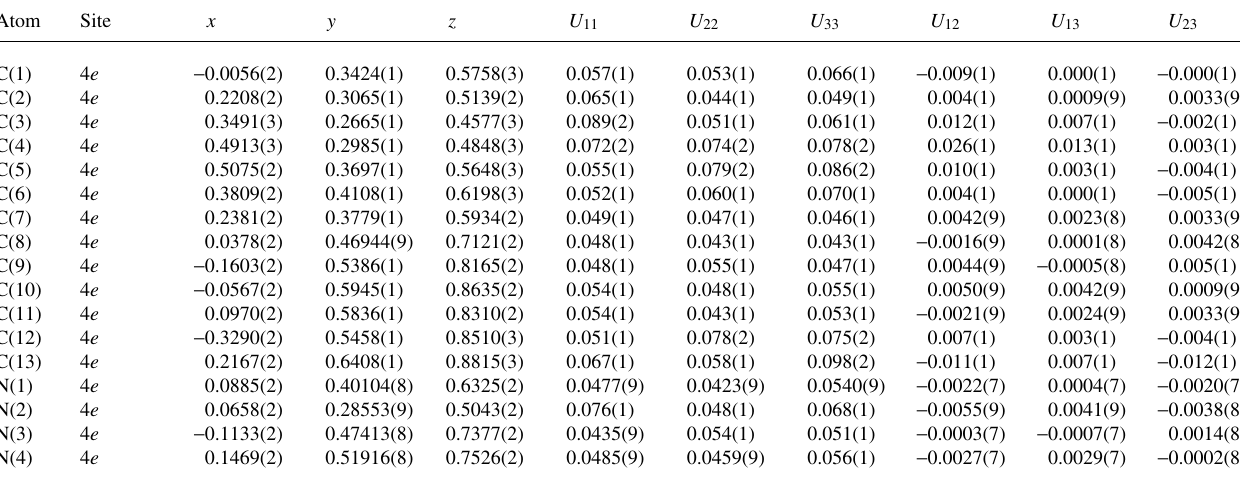
Table 3. Atomic coordinates and displacement parameters (in Å 2 )